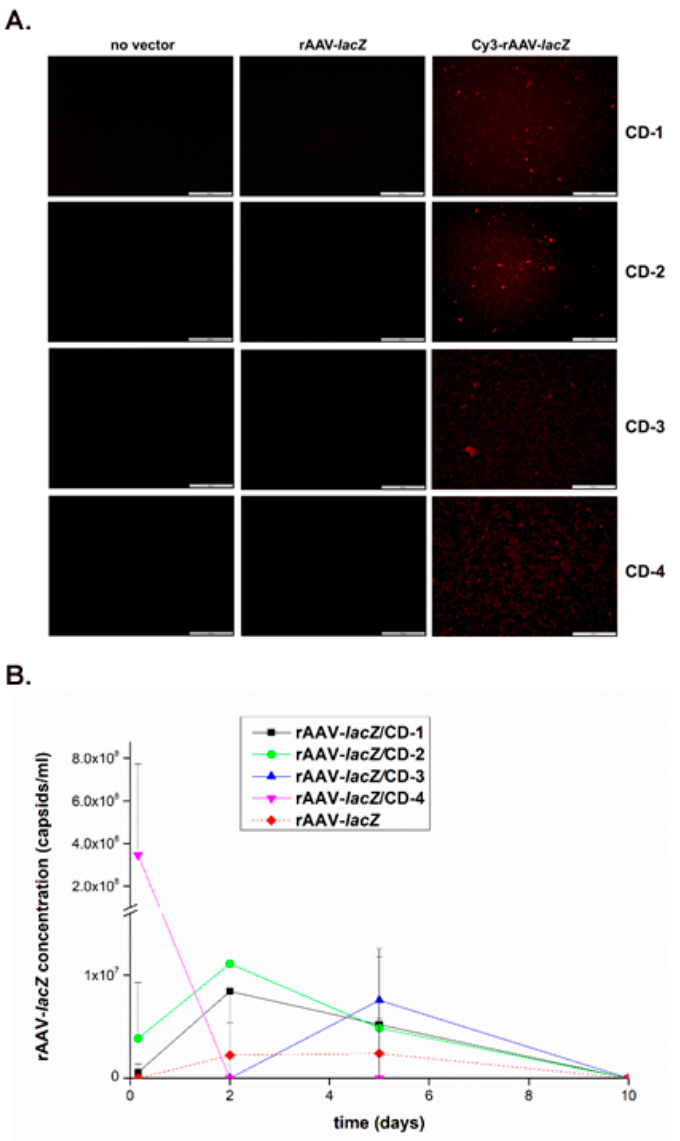
Figure 2. Complexation and release of rAAV vectors from the carbon dots. The rAAV- lacZ vector was labeled with Cy3 and formulated with the various CDs (40 µ L rAAV, 8 × 10 5 transgene copies / 40 µ L CD) and placed in culture over time. ( A ) Cy3-labeled rAAV formulated with the various CDs were examined under live fluorescence after 24 h (magnification × 10; scale bars: 100 µ m; all representative data). Control conditions included CD formulations with unlabeled rAAV, CDs lacking rAAV, and absence of CDs. ( B ) rAAV release from the various CDs was monitored by measuring the rAAV concentrations in the culture medium at the denoted time points using an AAV titration ELISA. Free vector treatment was used as a control condition.